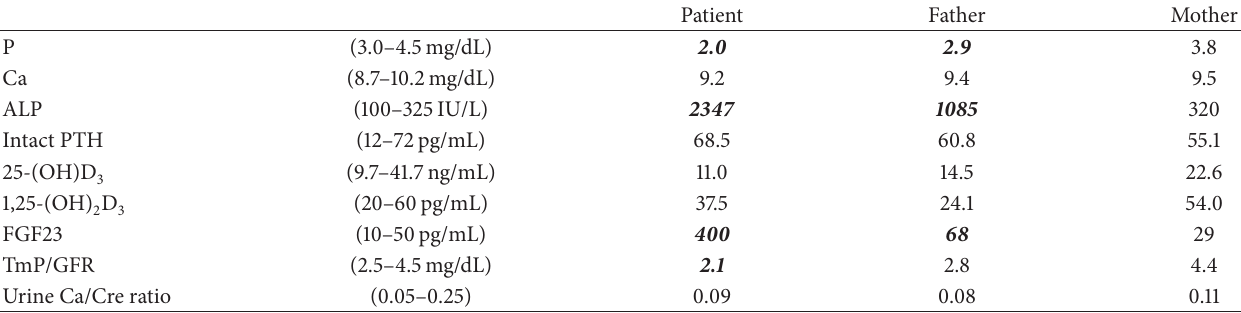
Table 1: Laboratory data of the patient, her father, and her mother.